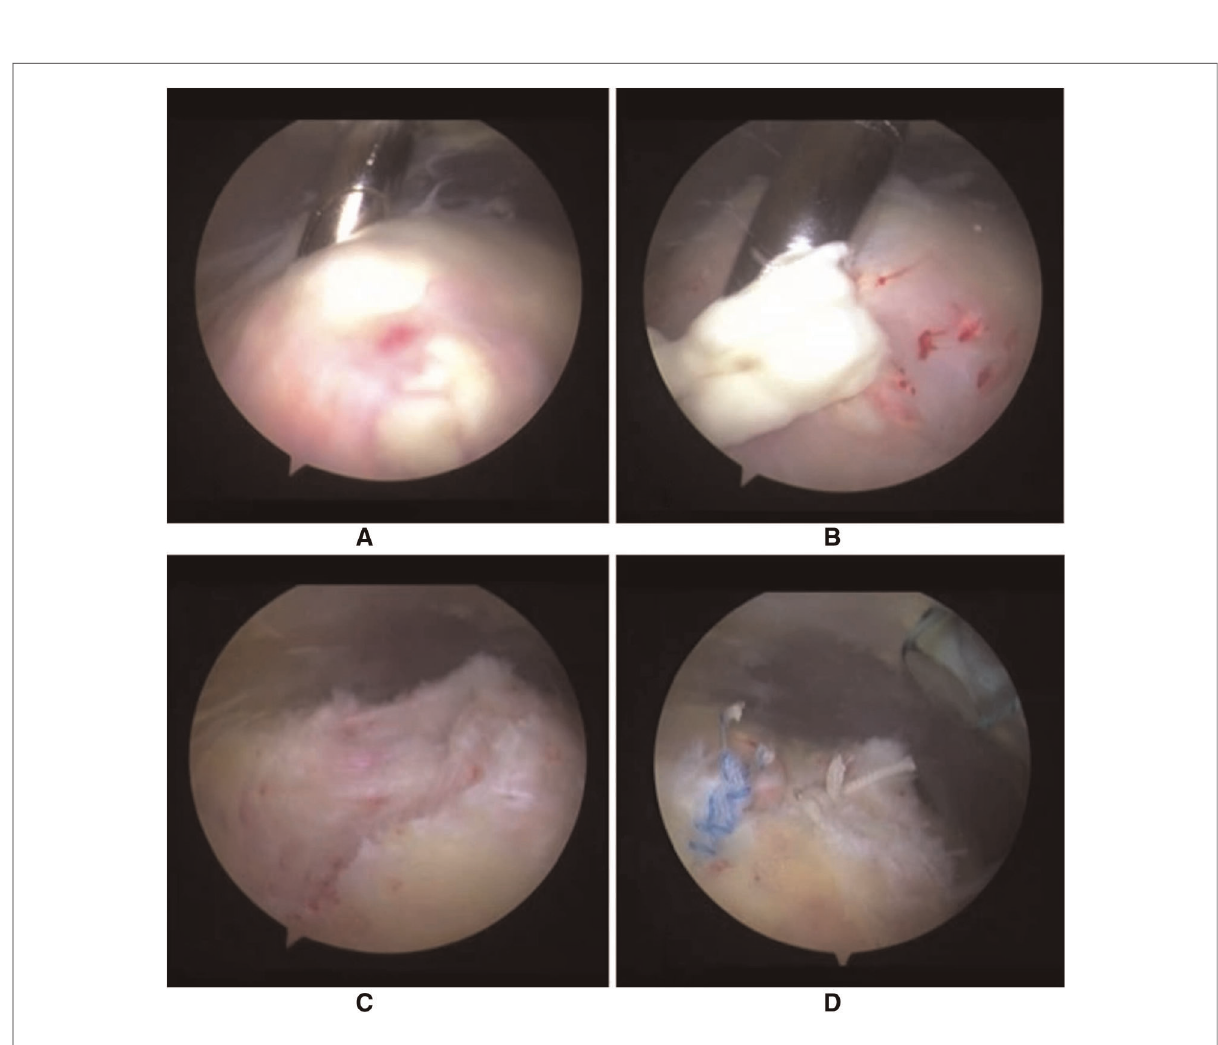
FIGURE 3 The calci fi c materials were found in ( A ) a more super fi cial location; ( B ) being removed; ( C ) a rotator cuff defect occurred after removal of calci fi c deposits; ( D ) the rotator cuff defect was repaired using one double-loaded